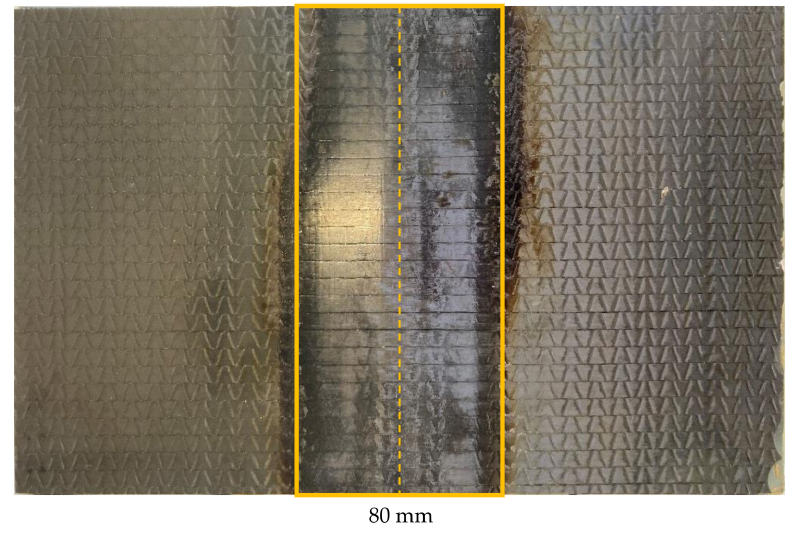
Figure 2. Example for a ‘matrix-repair’ CFRP plate (250 mm × 150 mm) after